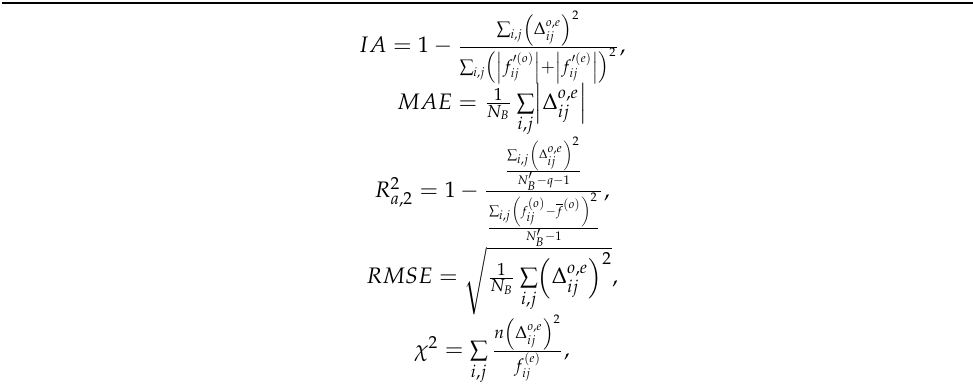
Table 4. The definitions of the goodness-of-fit measures applied for evaluating the bivariate distribu-